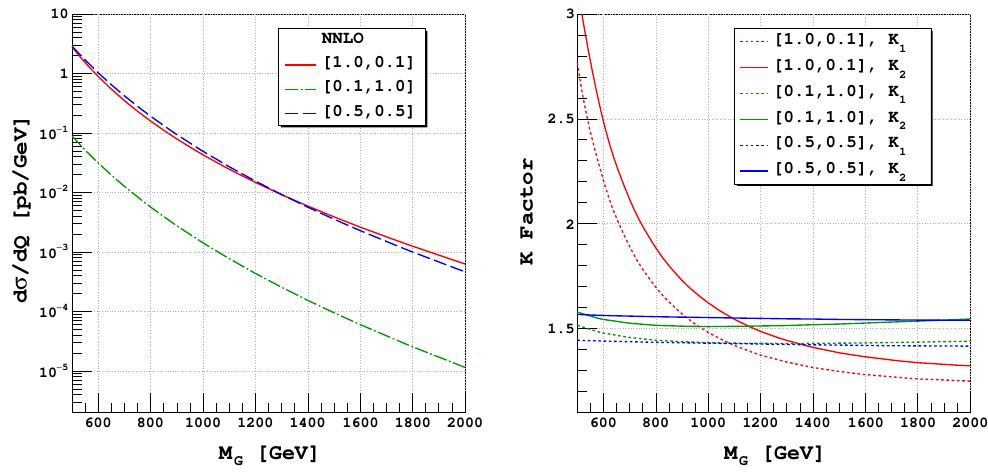
Figure 1 . Invariant mass distribution of the dilepton for signal for different choice of k q and k q at Q = M G in NNLO QCD (left panel) and the corresponding NLO and NNLO K-factor as defined eq. (3.1) (right